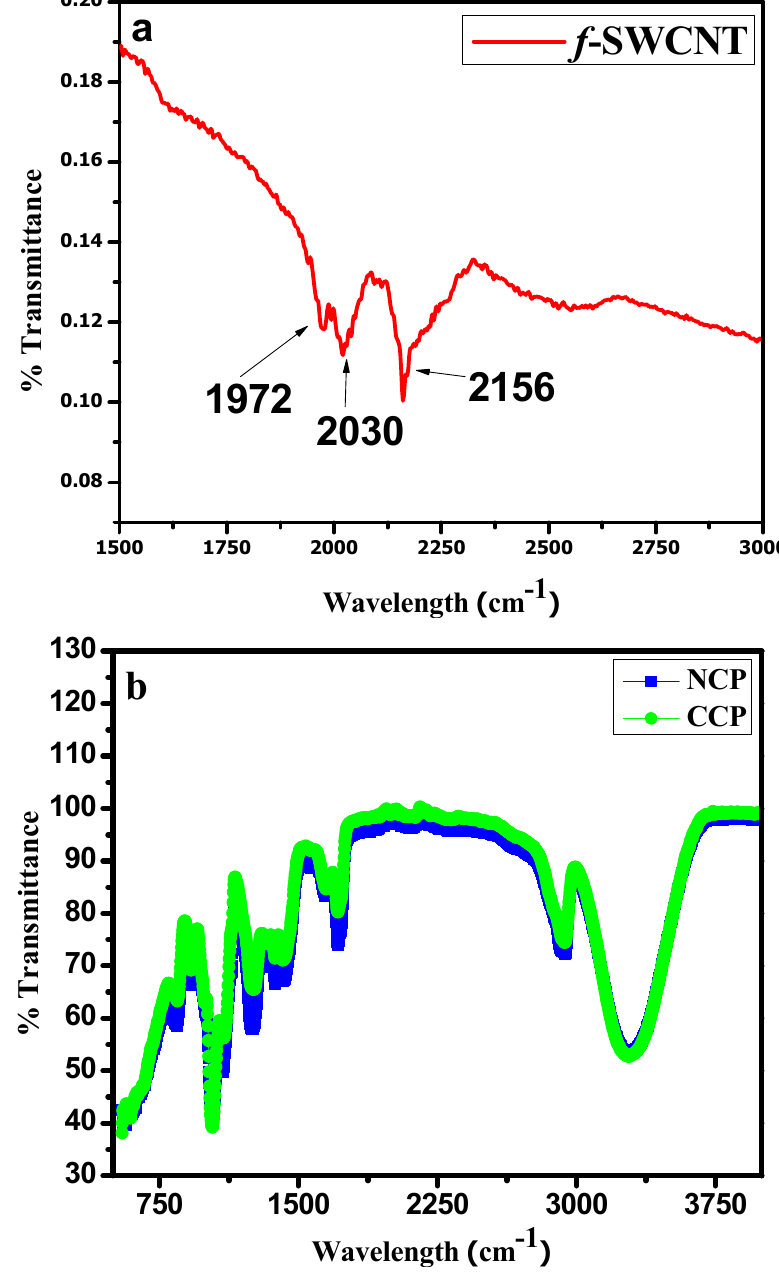
Figure 3. FTIR analyses of: ( a ) f- SWCNTs; ( b ) NCP and CCP. The dispersion of MOs and alignment of the SWCNTs was analyzed by SEM. Figure 4 shows the SEM micrographs of the NCP and CCP, analyzed at different resolutions.